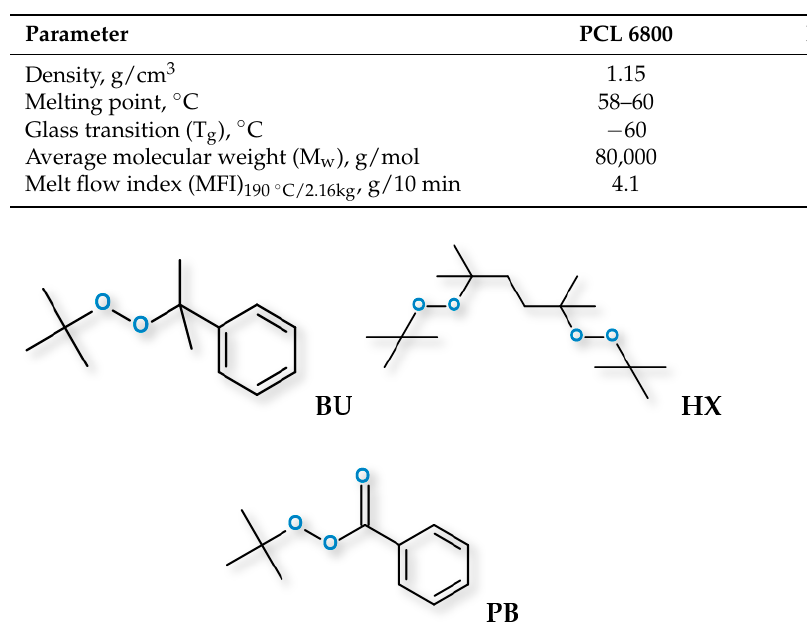
Table 1. The characteristics of the used materials.